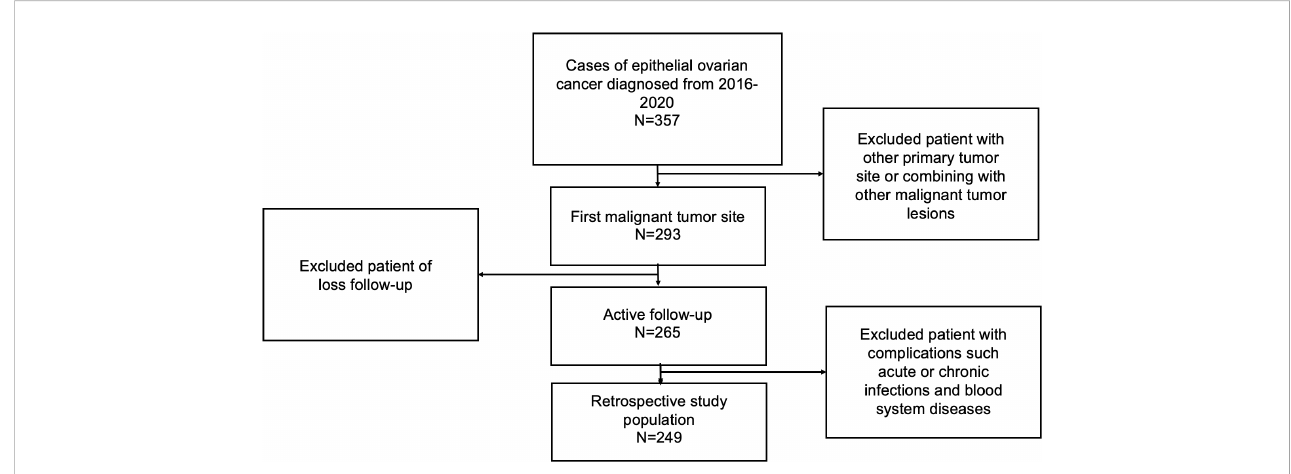
FIGURE 1 Work fl ow for selection procedure of epithelial ovarian cancer